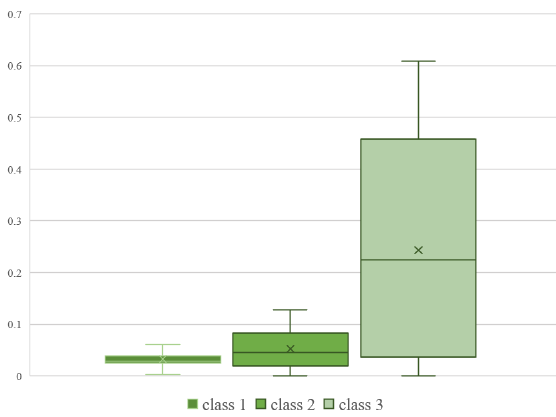
Figure 5. Distribution of data by